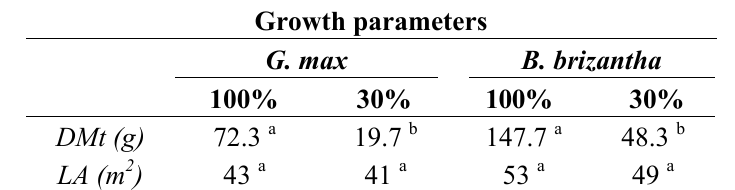
Table 6. Mean values of total dry mass ( DMt ) and leaf area ( LA ) in G. max and B. brizantha under different water regimes (100% and 30% refill of the total amount of the evapontranspired